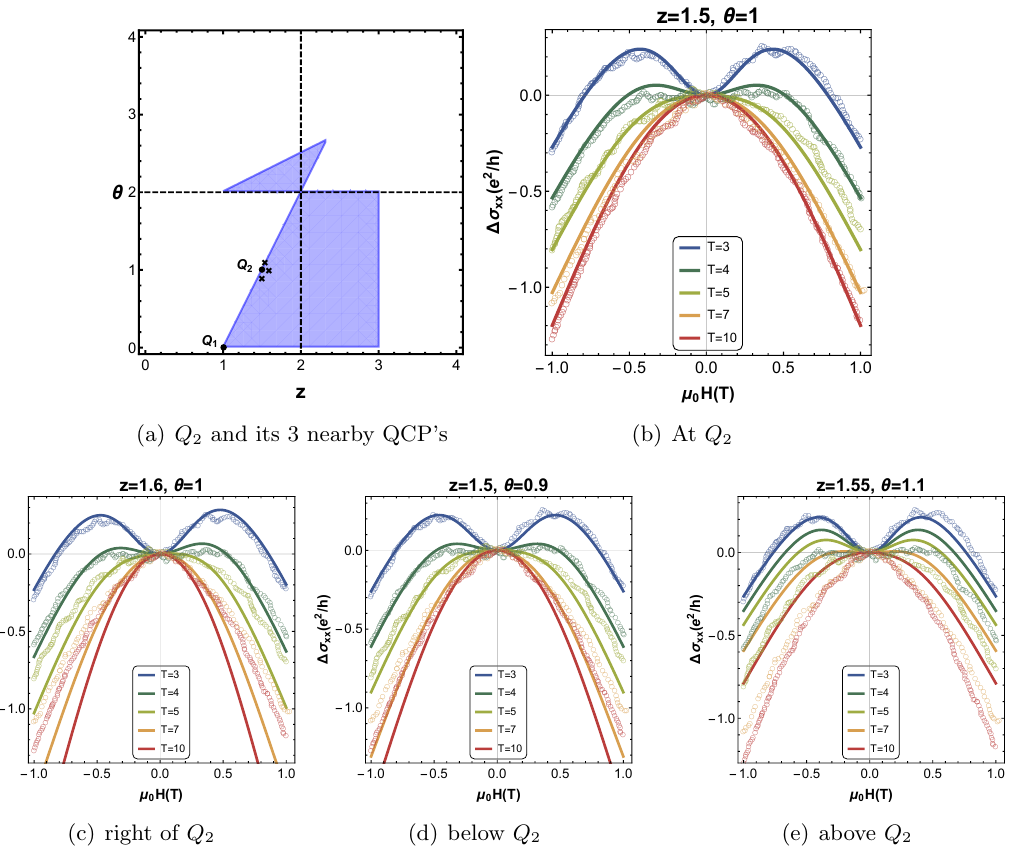
Figure 4 . (a) Two quantum critical point Q 1 ; Q 2 : Q 1 is for Cr doped Bi 2 Te 3 discussed in [45] and Q 2 is for Mn doped for Bi 2 Se 3 which is the topic here. (b,c,d,e) The uniqueness of Q 2 , the QCP with ( z; (cid:18) ) = (3 = 2 ; 1). The data is for Mn 0 : 04 (Bi 2 Se 3 ) 0 : 96 taken from ref. [47]. Solid line and circles are for theory curve and experimental data respectively. The (cid:12)tting is good at Q 2 as one can see in (b). But as we deviate from it, the (cid:12)tting becomes bad rapidly for high temperature data. See